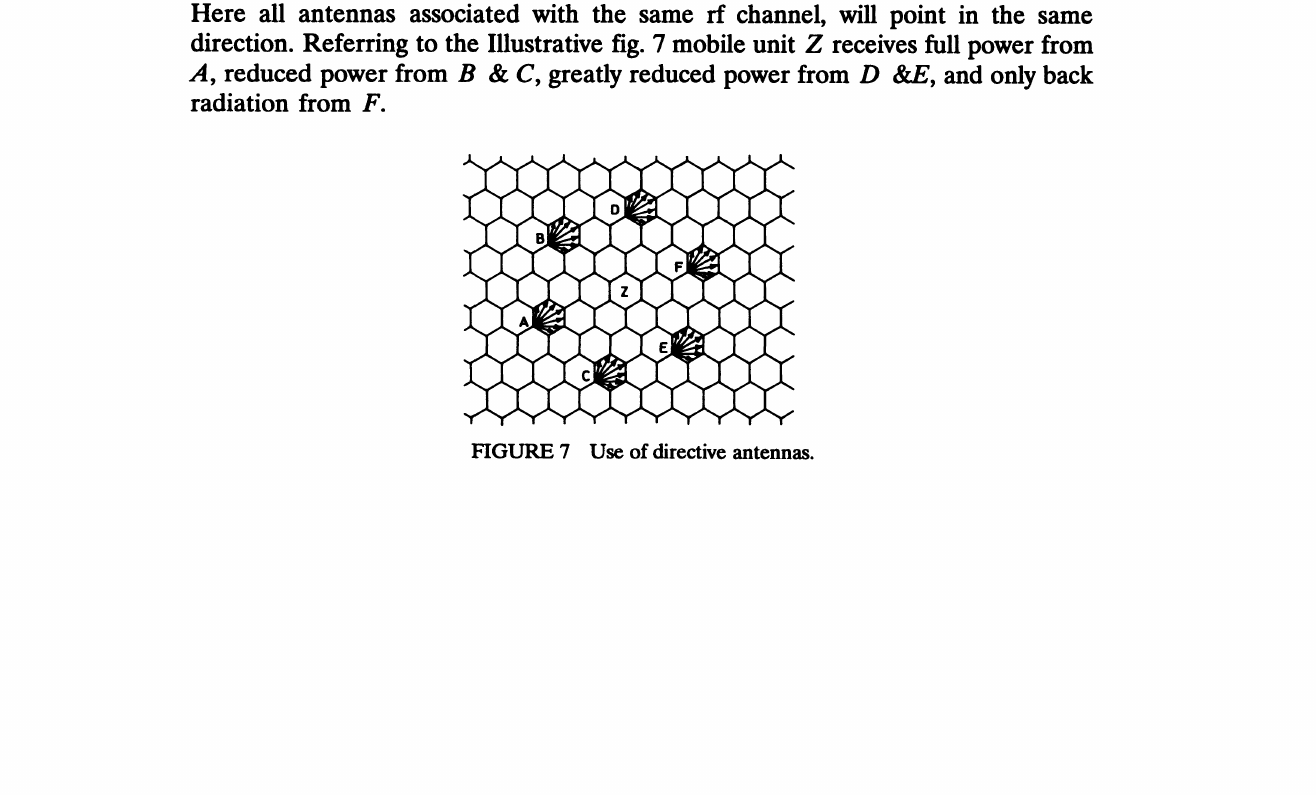
FIGURE 7 Use of directive